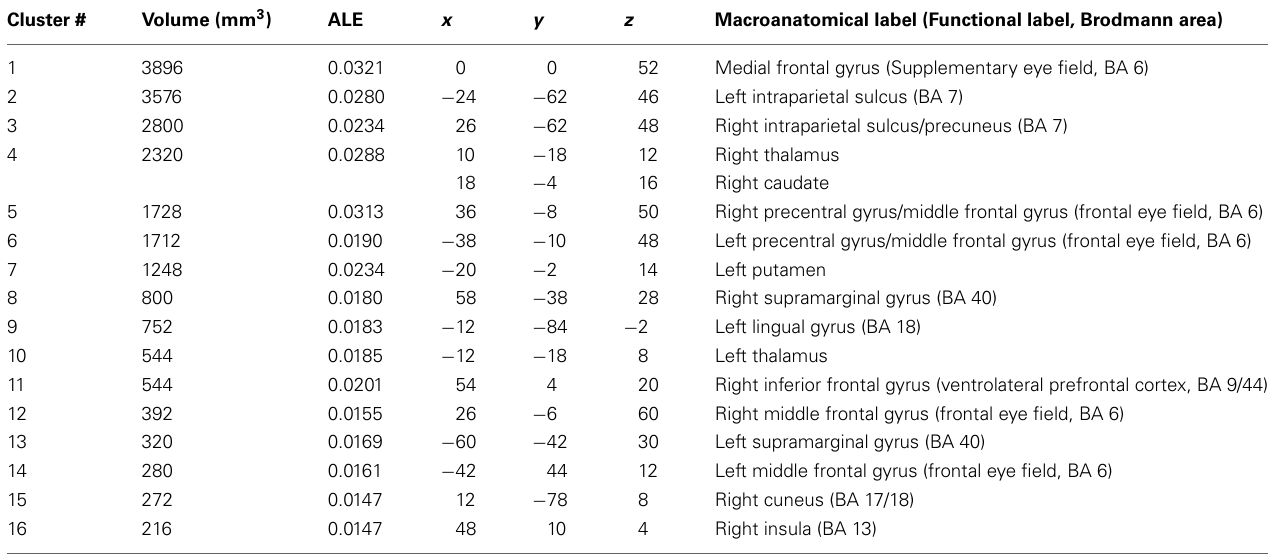
Table 2 | Talairach coordinates, volume (mm 3 ), ALE values and anatomical labels for the antisaccade > fixation analysis. Cluster